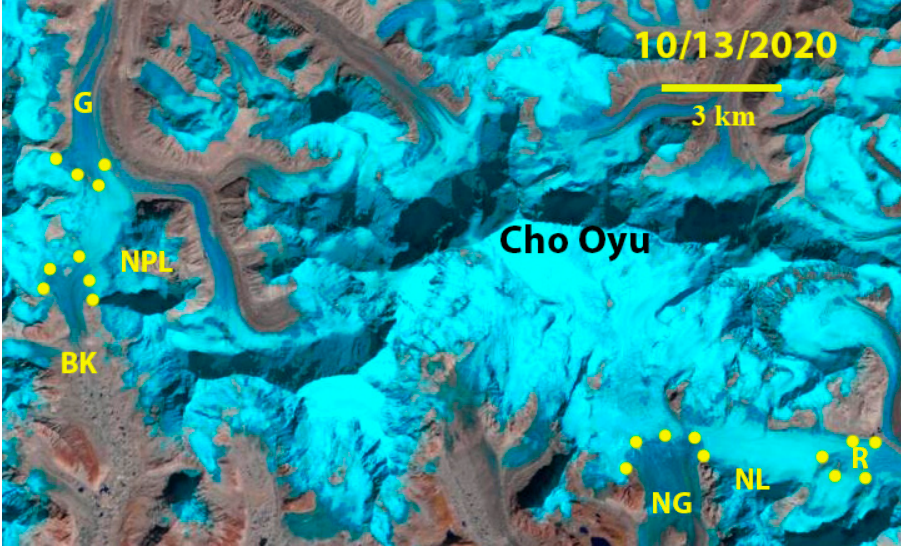
Figure 2. Glacier snow line on Mount Everest glaciers on 13 October 2020 as per a Landsat image. NG = Ngozumpa Glacier; NL = Nup La; R = Rongbuk West Glacier; NPL = Nangpa La; G = Gyabrag Glacier and BK = Bhote Koshi Glacier. Yellow dots mark locations of snow line elevation determination.